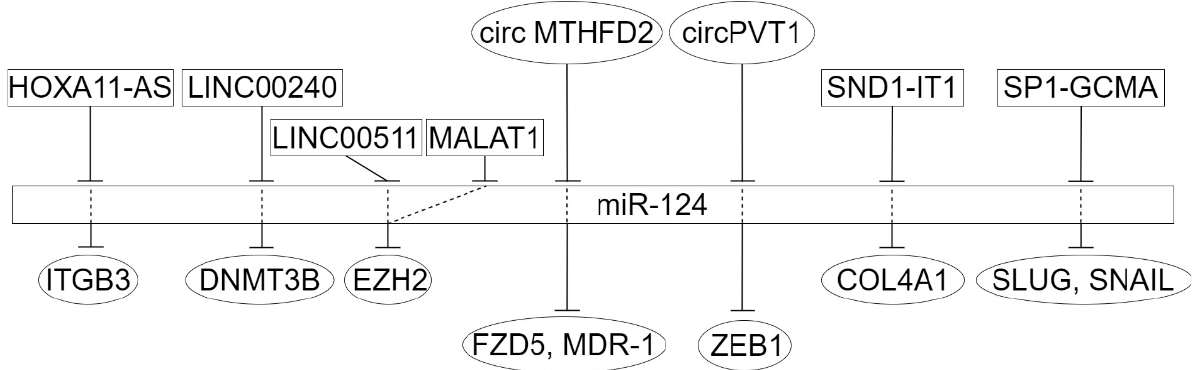
Figure 4. MiR ‐ 124 regulatory sub ‐ network in gastric cancer. LncRNAs are given inside the rectan ‐ Figure 4. MiR-124 regulatory sub-network in gastric cancer. LncRNAs are given inside the rectangles, gles, circRNAs are in ovals at the top, protein targets are in ovals at the bottom. circRNAs are in ovals at the top, protein targets are in ovals at the bottom.